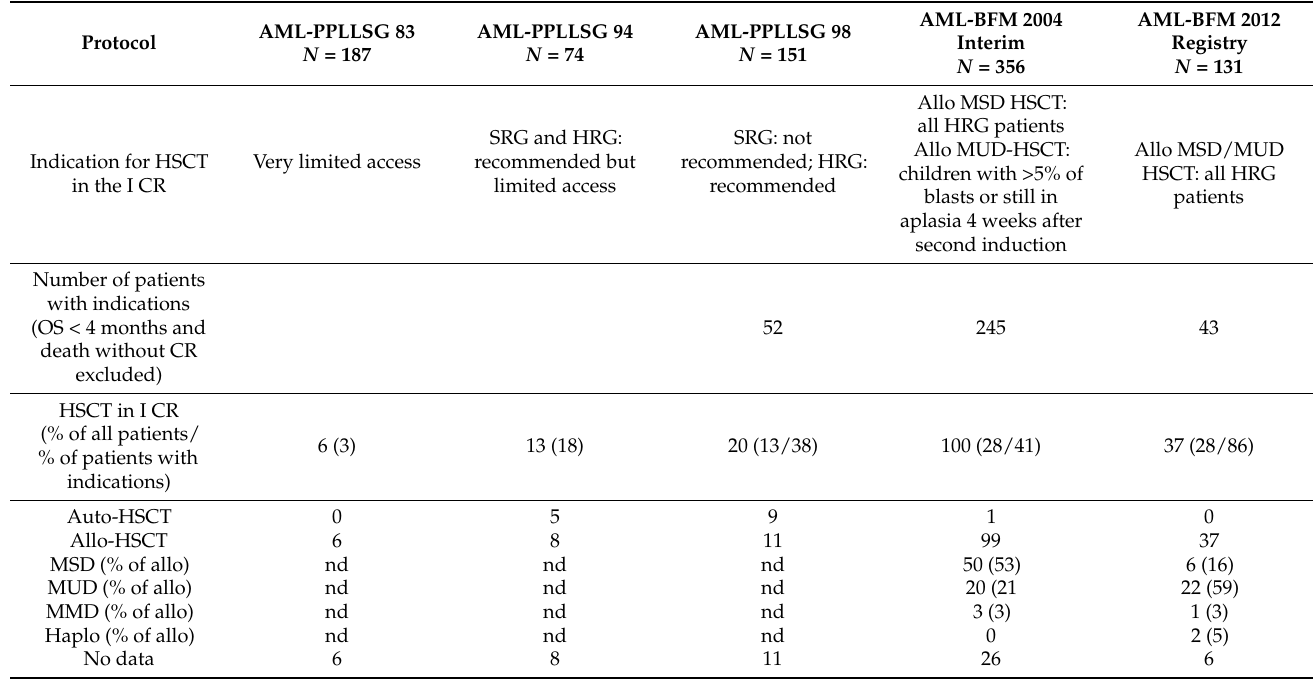
Table 4. Hematopoietic stem cell transplantation (HSCT) in the consecutive